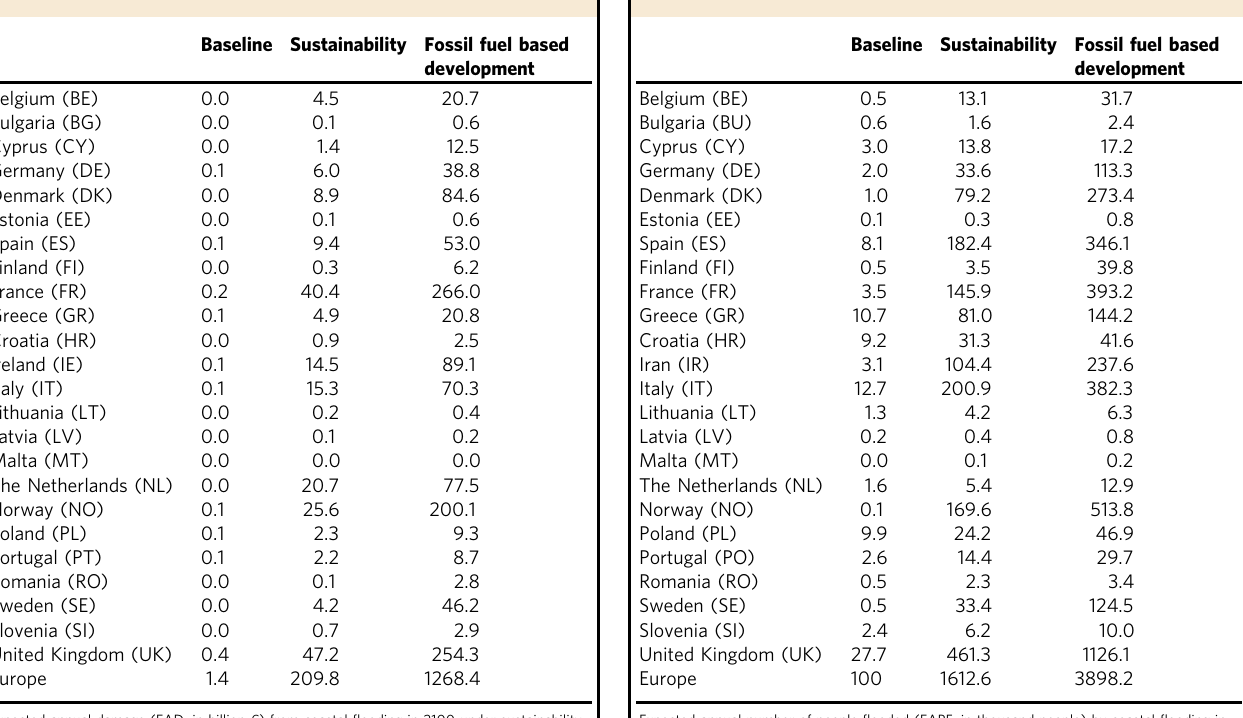
Table 2 People fl ooded without any future adaptation